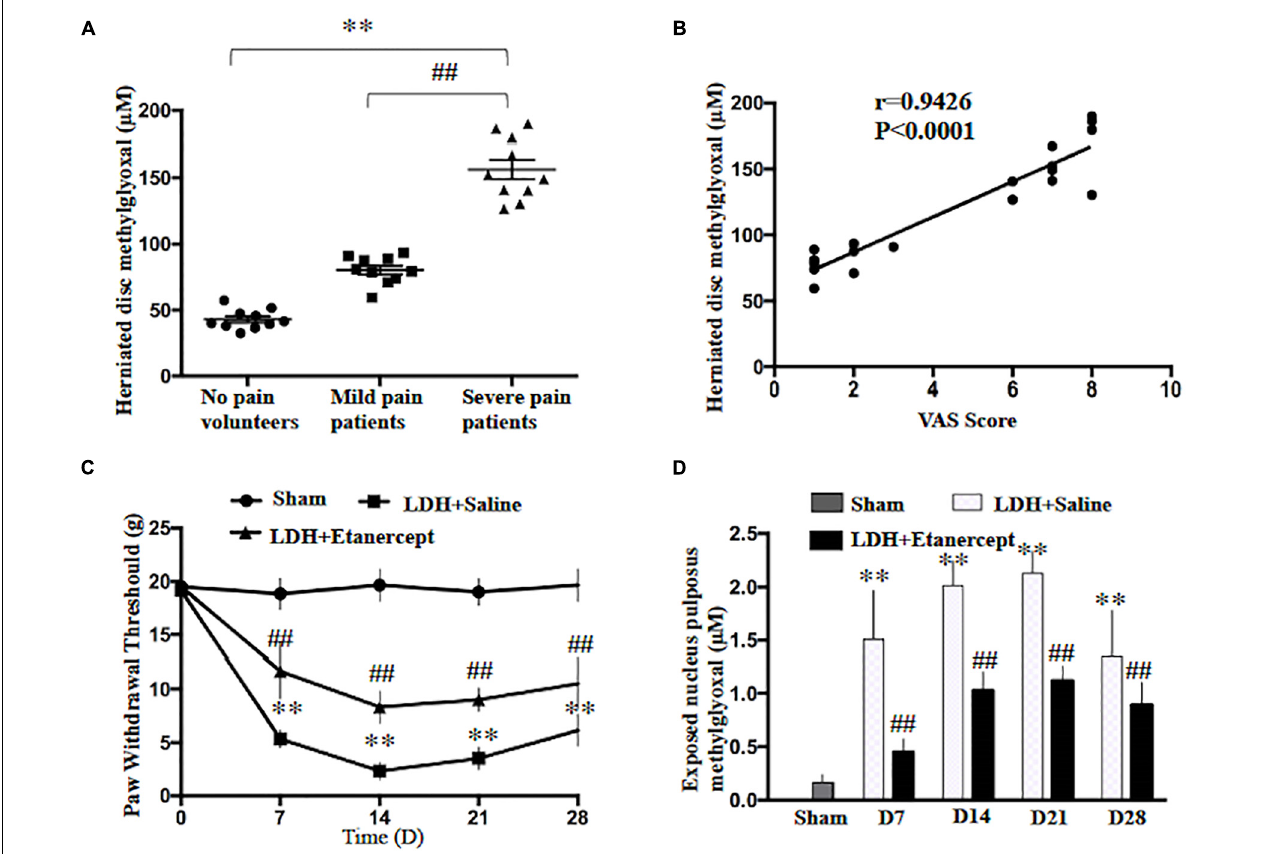
FIGURE 1 | Lumbar-herniated disc (LDH)–induced radicular pain and methylglyoxal (MG) accumulation in herniated disc. (A) MG levels were evaluated in herniated disc of the patients or volunteers (One-way ANOVA: F = 143.679, p < 0.001; post hoc Dunnett: ∗∗ p < 0.001, volunteers with no pain vs. patients with severe pain. ## p < 0.001 patients with mild pain vs. patients with severe pain, n = 10). (B) The analysis of linear correlation between visual analog scale (VAS) and the herniated disc MG level in patients. (C) The paw withdrawal threshold of rats was significantly decreased following NP implantation (Two-way ANOVA: F = 3.893, p =